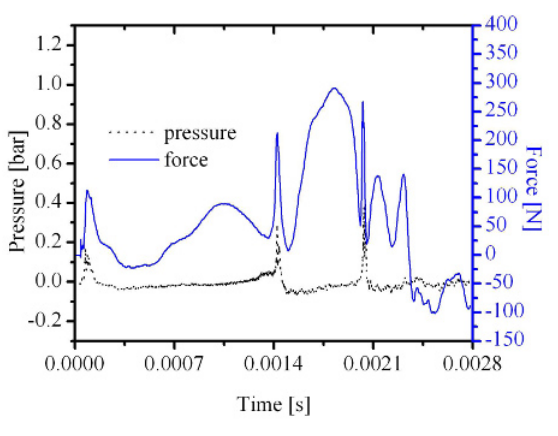
Fig. 8. Collapse pattern 3 – hydrophone and PVDF film